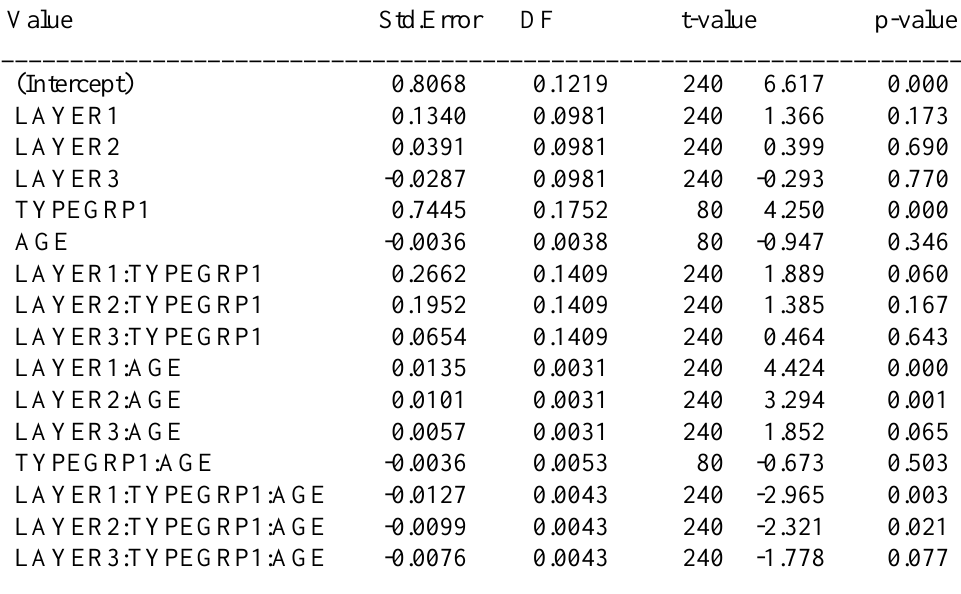
Table A1. The model